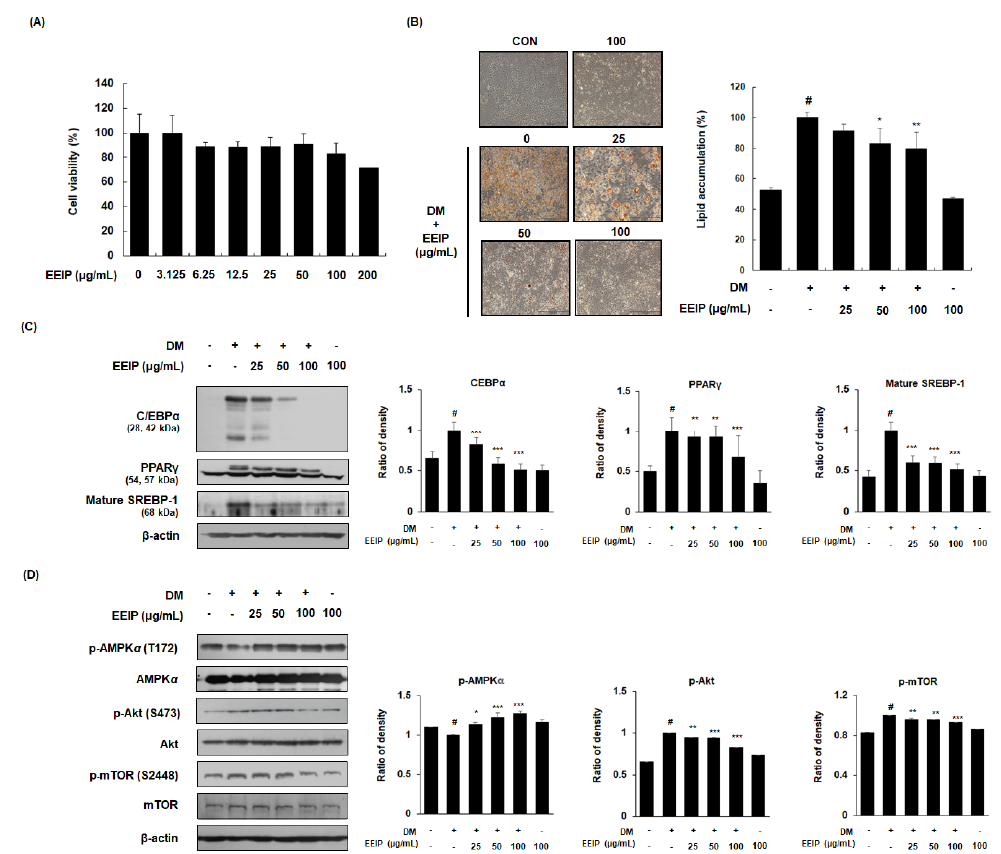
Figure 2. Effect of EEIP on adipocyte differentiation in 3T3 − L1 preadipocytes. ( A ) Cell viability was measured using the MTT assay under growth media conditions, with or without EEIP (25, 50, or 100 µ g/mL). ( B ) Relative microscopic images and quantitative data of lipid accumulation. For assessment of lipid accumulation, cells were differentiated into adipocytes in DM with or without EEIP (25, 50, or 100 µ g/mL) and then oil red O staining was performed. ( C , D ) The protein levels of adipogenic transcription factors and the activation of AMPK and the Akt/mTOR pathway in DM − treated cells, with or without EEIP (25, 50, or 100 µ g/mL) were analyzed by Western blotting. β -actin was used as the internal control. Densitometric analysis was performed using Bio-Rad Quantity One Software (BioRad; Hercules, CA, USA). Values are represented as the mean ± SD. # p < 0.05 vs. the GM group, * p < 0.05, ** p < 0.01, and *** p < 0.001 vs. the DM